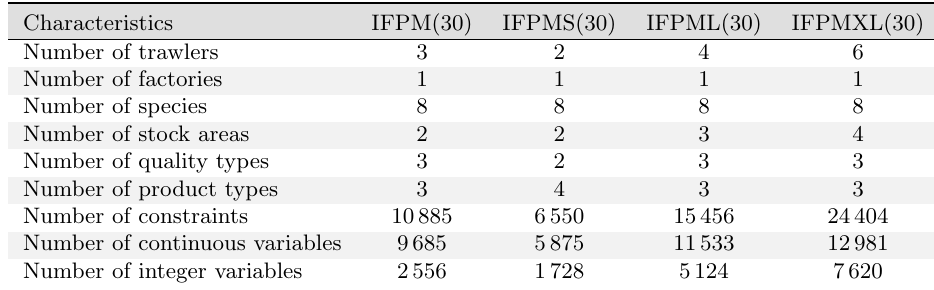
Table 1: A summary of the characteristics of four different problem instances. Each runs over a 30 day planning